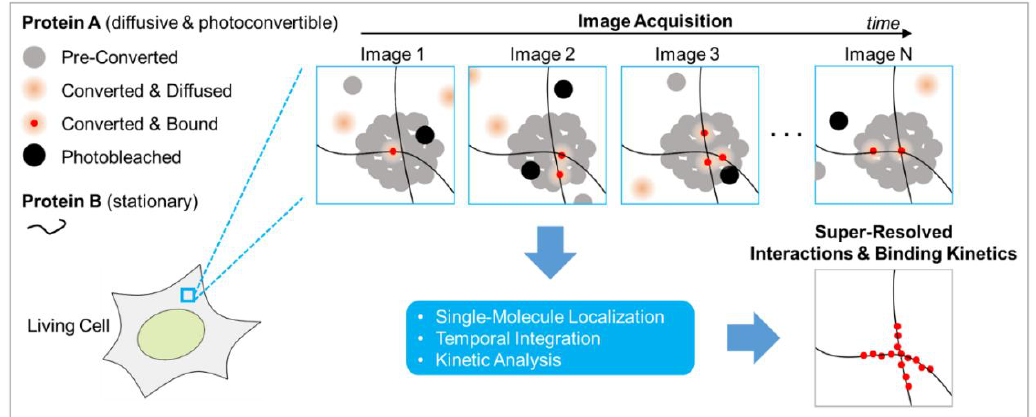
Figure 2. Principle of super-resolution imaging of biomolecule interactions with PAINT-PALM. For illustration purpose, the interactions between a di ff usive protein A and a stationary protein B are shown here. The concept is readily generalizable to the imaging of protein-DNA or protein-RNA interactions in the nucleus, by replacing protein B with DNA or RNA in the figure. Here, the di ff usive protein A is fused to a photoconvertible fluorescent protein (FP) and expressed in living cells. During experiment, the chimeric protein A (ligand) is stochastically photoconverted to fluoresces. On camera, the images of unbound protein A molecules appear motion-blurred because of di ff usion. The images of protein A molecules interacting with protein B appear as sharp spots with well-defined Gaussian PSF, after transient immobilization. The interactions are sampled over time by acquiring an image sequence (image 1, 2, 3, ... , N ). Super-resolved interaction map is generated by single-molecule localization and temporal integration. The temporal image sequence may also be subjected to additional analysis such as tcPALM to extract information on binding kinetics.